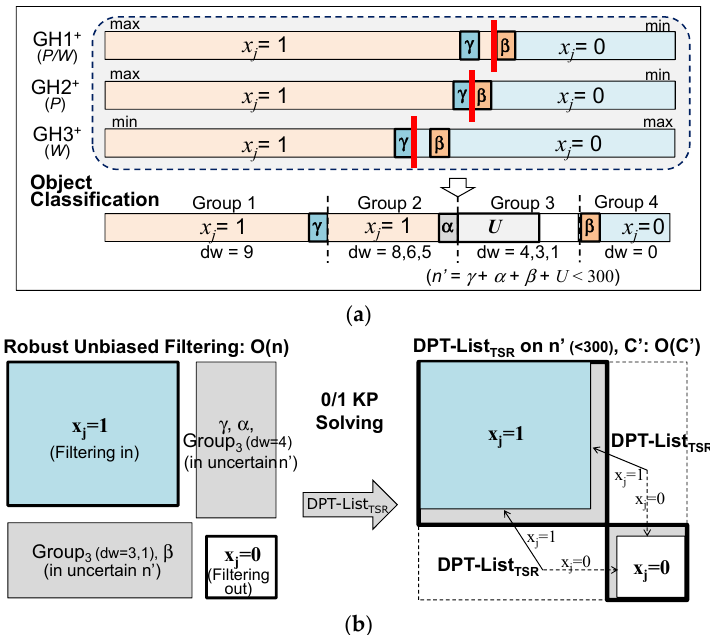
Figure 19. High (optimal) precision of robust unbiased filtering for each K i of 0/1-mKP: ( a ) object classification and ( b ) robust unbiased filtering and DPT-List TSR for remaining n ’ < 300.